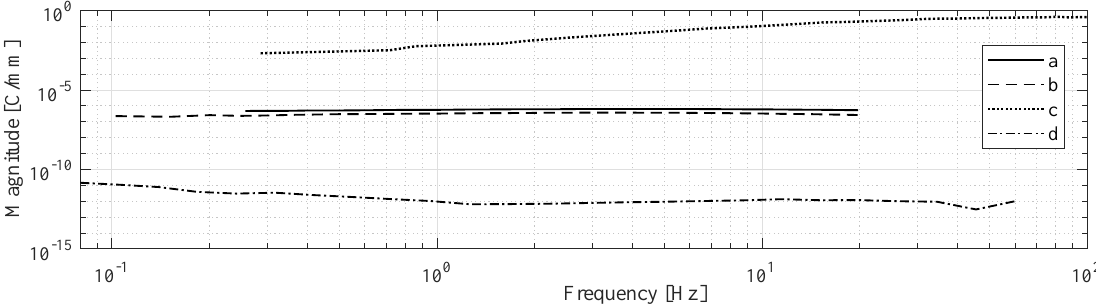
Figure 11. Reported frequency responses for IPMC charge sensing according to [125] ( a ), [89] ( b ), [119] ( c ), and [133] ( d